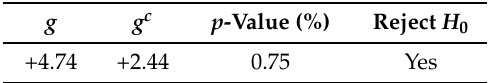
Table 11. Global time stability test (95%) of the parameter γ ◦